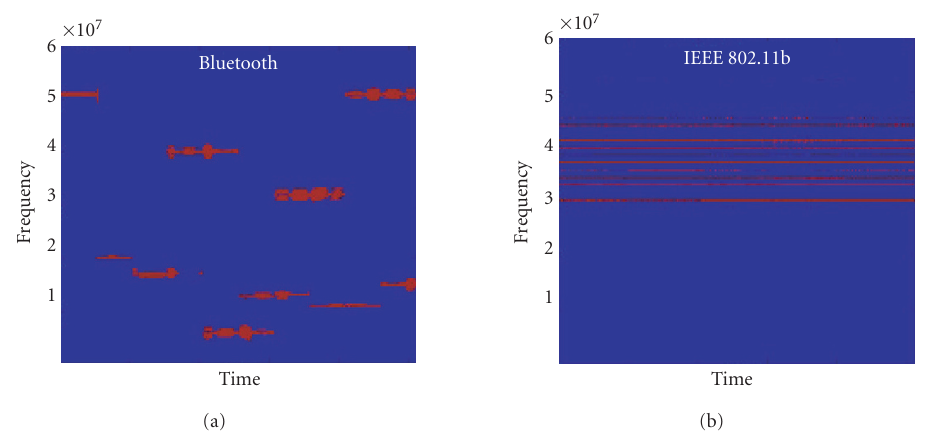
Figure 2: Time-frequency transforms of the two standards: (a) Bluetooth, (b) IEEE 802.11b.